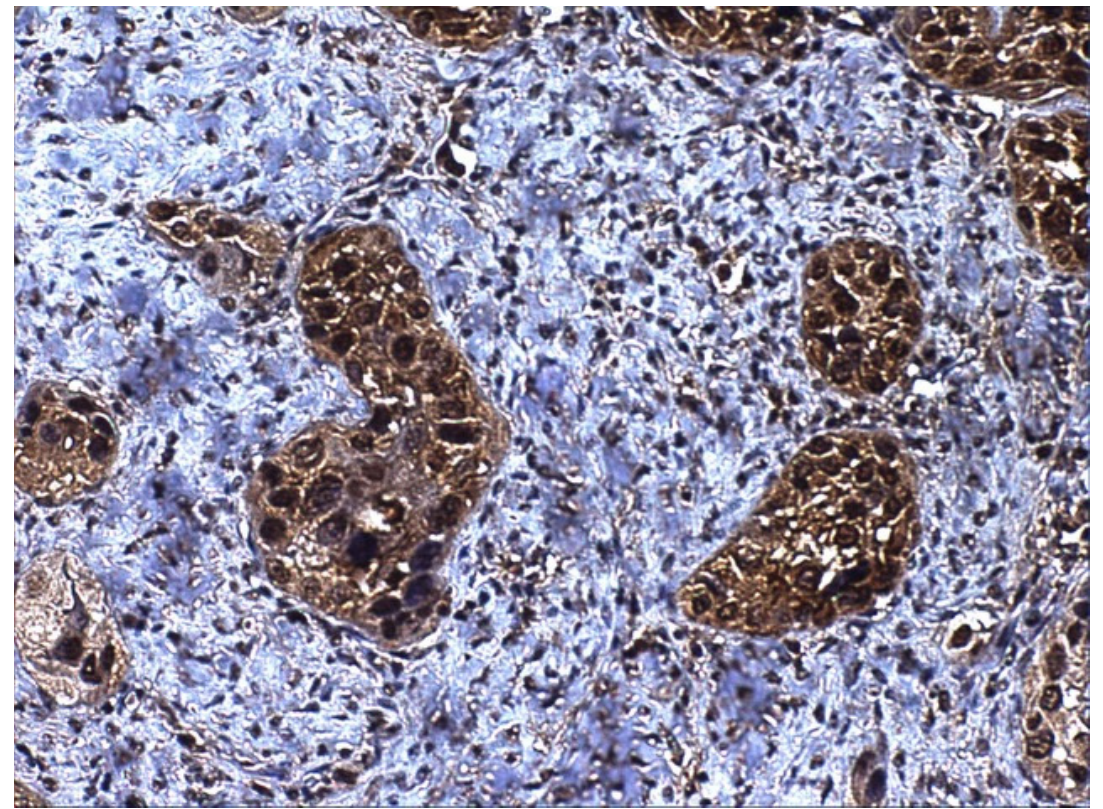
Figure 4. SP immunostaining of both cytoplasm and nuclei of neoplastic squamous cells in laryngeal carcinoma.